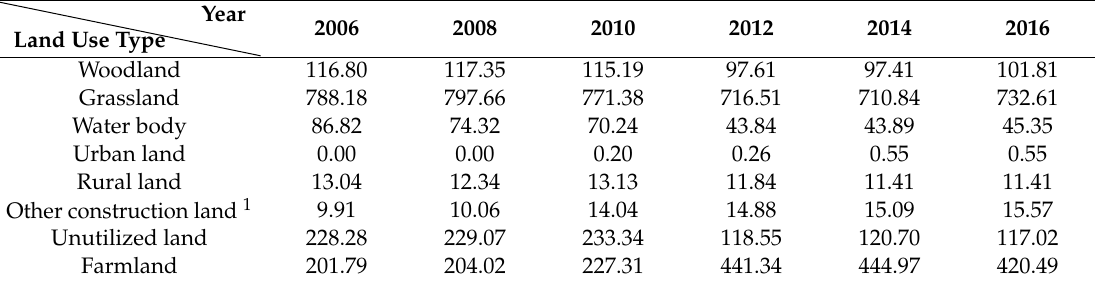
Table 3. Land use area of the HJN watershed from 2006–2016 (km 2